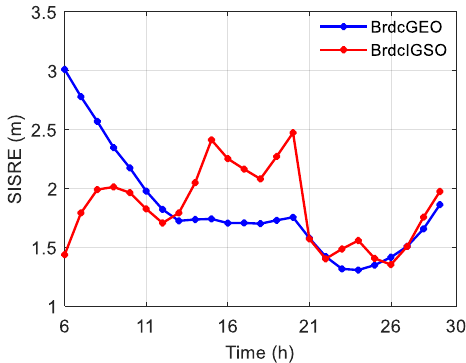
Figure 4. Average orbit-only signal-in-space ranging errors (SISREs) of the healthy broadcast ephemerides in each hour after maneuvering of GEO and IGSO satellites in 2017.